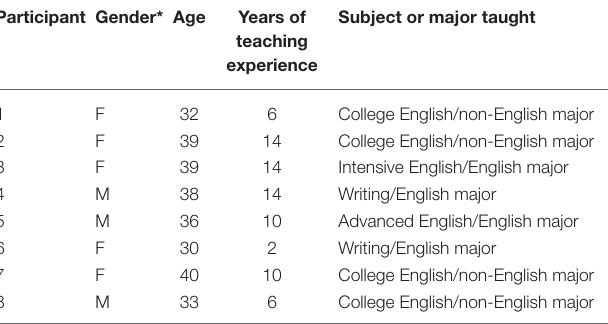
TABLE 2 | Biographical information of the participants.